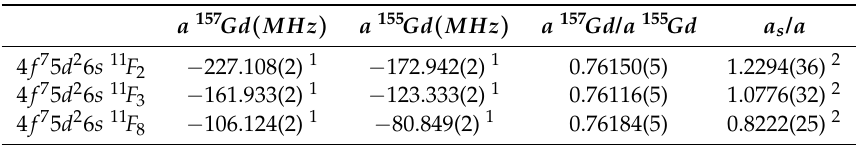
Table 3. Hyperfine interaction constants in Gd.